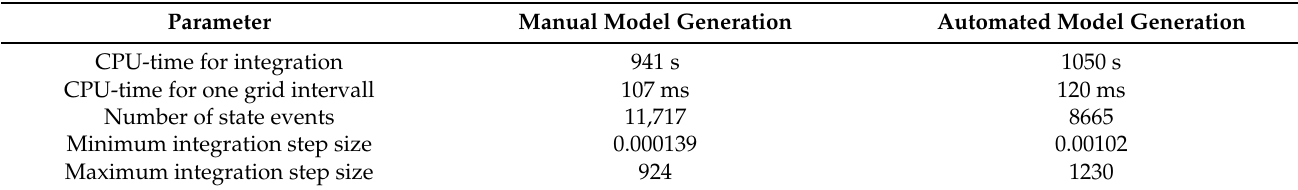
Table 3. Comparison of numerical parameters of manual and automated model generation.